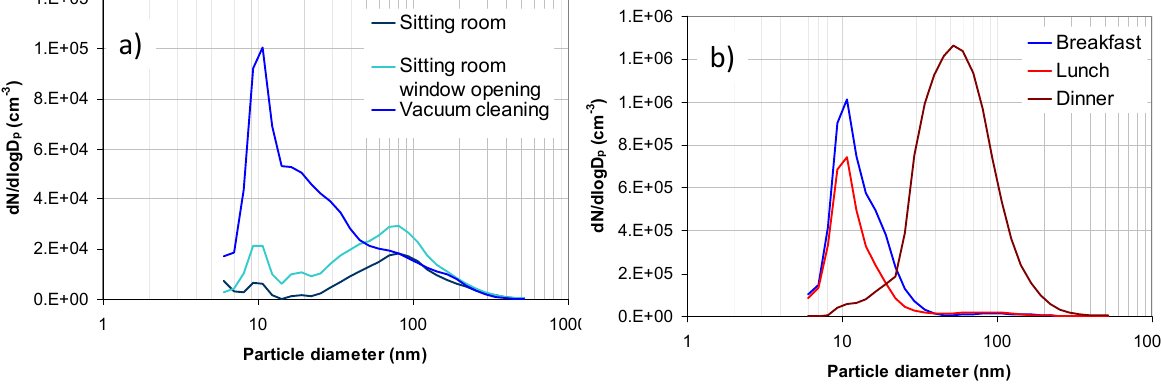
Figure 2. Aerosol size distribution at the maximum particle concentration value ( a ) in a living room with no aerosol generation and during vacuum cleaning and ( b ) in a kitchen during breakfast, lunch and dinner preparation and